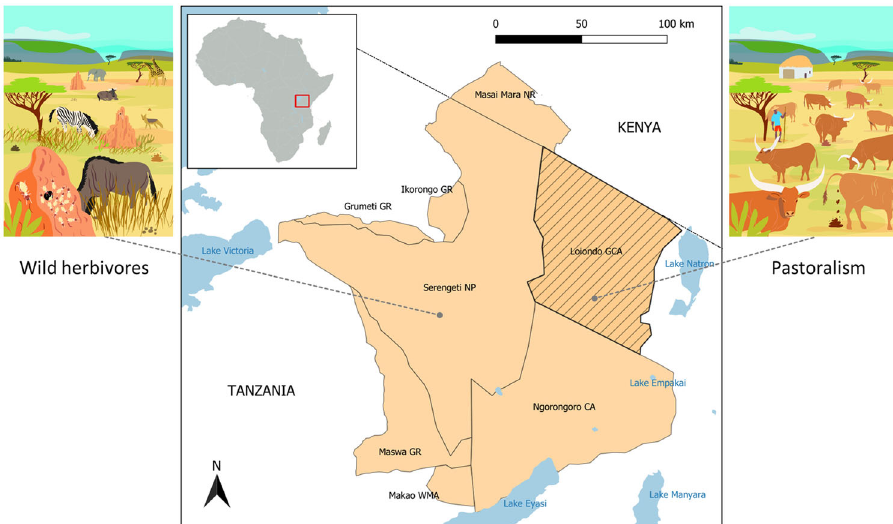
Fig. 1 Location map of the Serengeti ecosystem and Loliondo Game Controlled Area (GCA). The Serengeti ecosystem is representative of an African savanna dominated by wild herbivores, while the Loliondo GCA is a similar ecosystem but where pastoralist livestock dominates herbivory processes. Illustrations of the dominant herbivores reproduced, with permission, from Manzano & White 8 . Note that termites are not considered in the present study and should, in principle, be equally abundant in both systems (see Supplementary